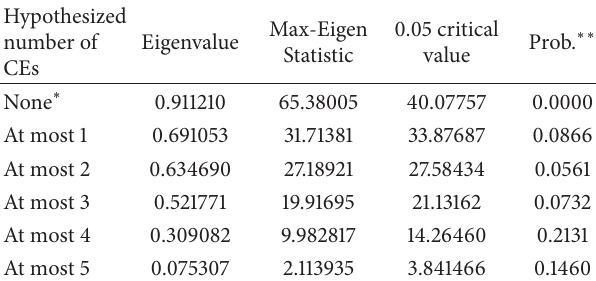
Table 2: Cointegration test results.